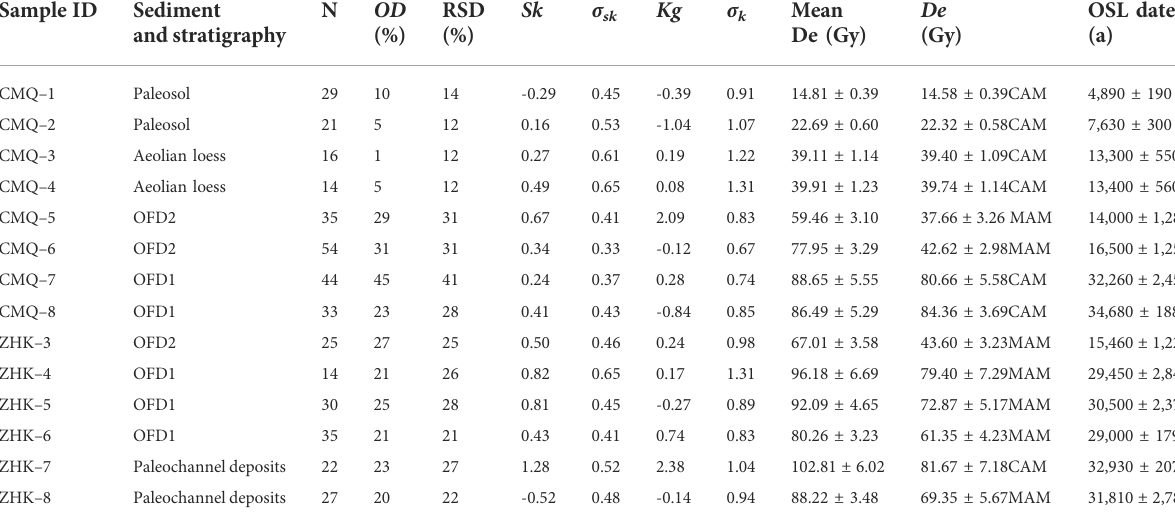
TABLE 5 The equivalent dose values and OSL ages for samples taken from overbank fl ood deposits (OFD), paleosol, aeolian loess, paleochannel deposits, and glacial outwash/ fl ash fl ood deposits in the CMQ and ZHK pro fi les in the Yellow River source area on the NE Tibetan Plateau.